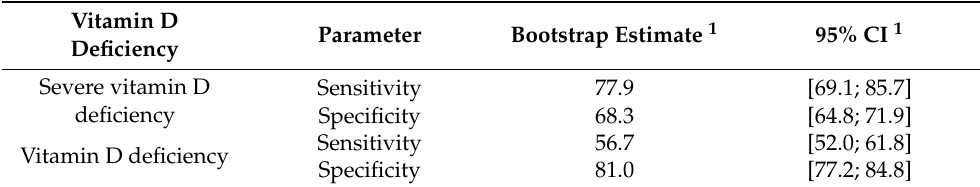
Table 4. Performance of the model to predict vitamin D deficiency and severe vitamin D deficiency with a threshold of 50